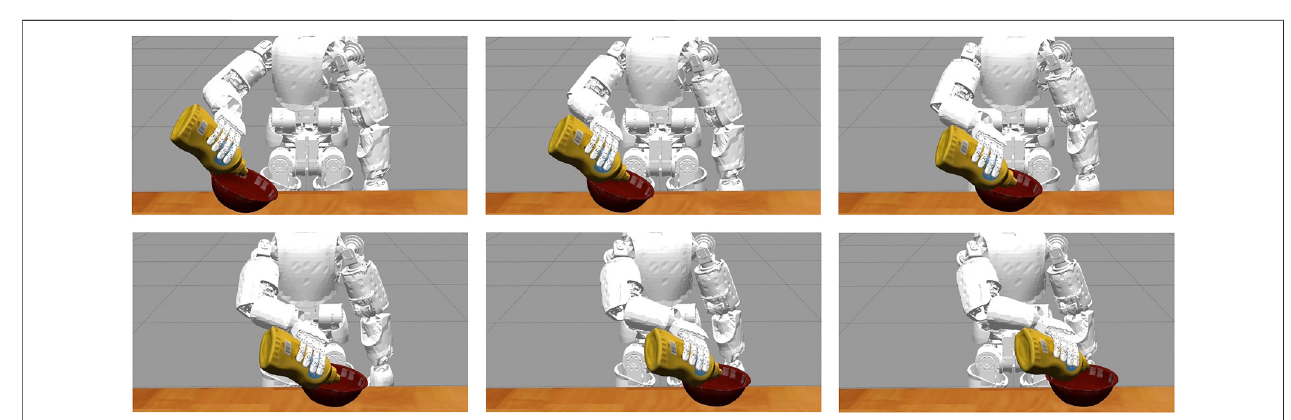
FIGURE 6 | The iCub robot in the Gazebo environment while it follows a moving container (red bowl) during a pouring task using the estimate of the pose and velocity of the container as feedback signal.